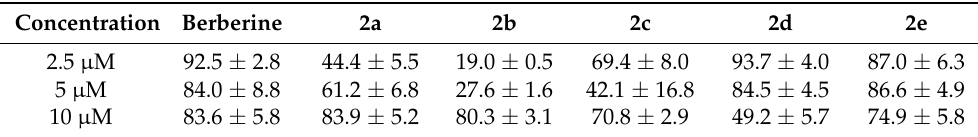
Table 1. The results of the MTT assay for cell viability. The data are presented as percentage of the control group.